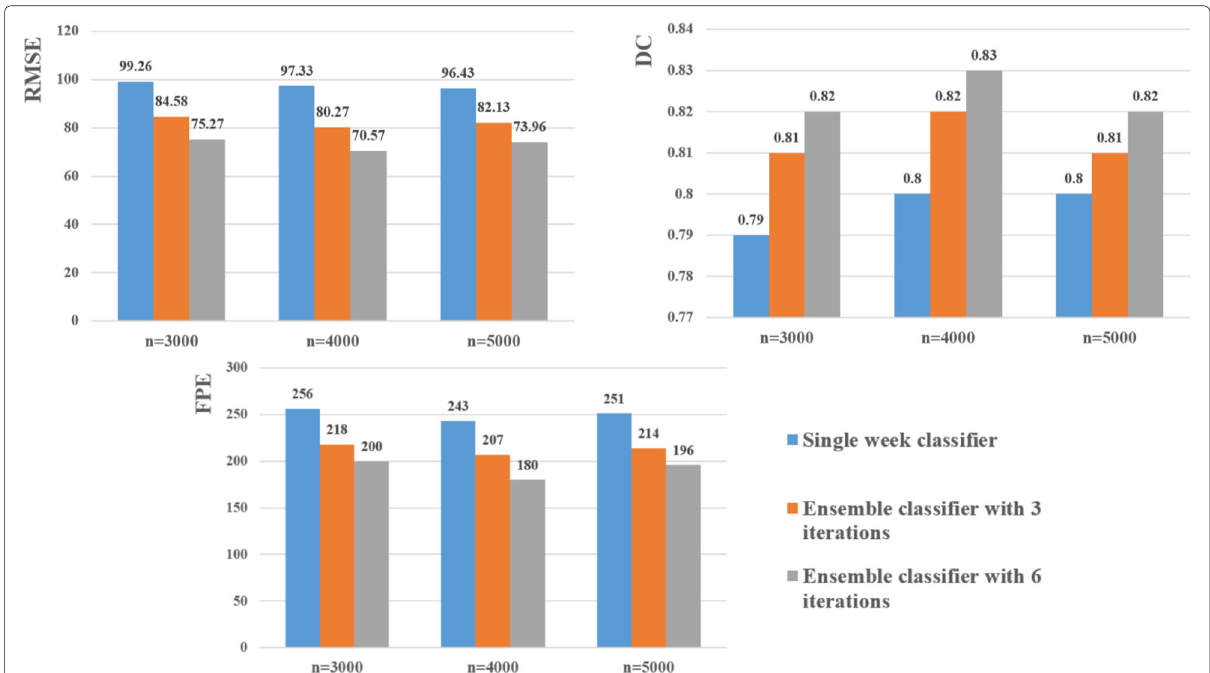
Fig. 4 Comparison of RMSE, DC, and FPE values achieved by the proposed model with different parameters. Detailed legend: We show the prediction results of the proposed model with different parameters, i.e., sampling number of samples in SMOTE method and training iterations in AdaBoost training strategy, in Fig. 4, where n refers to the number of sampling samples